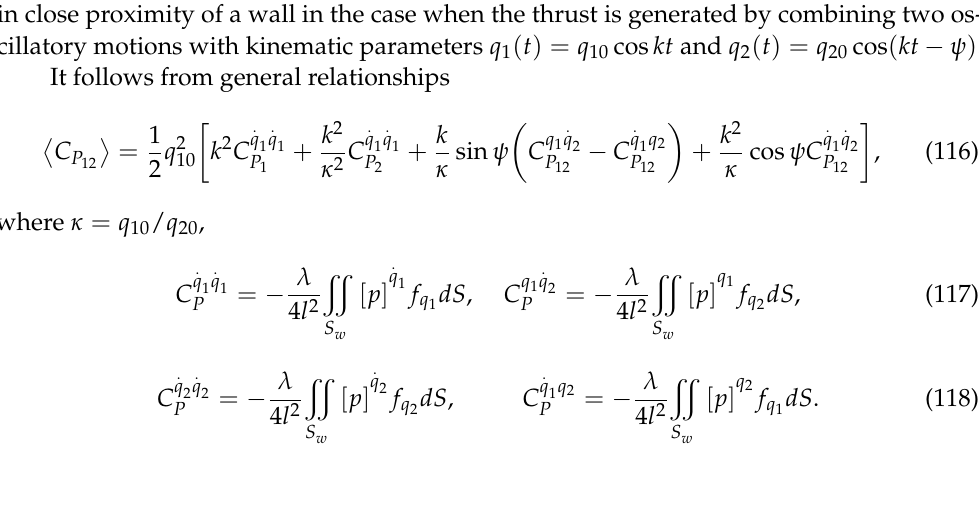
Figure 17. Thrust in the case of combined heaving-pitching oscillations related to that for purely heaving oscillations versus amplitude ratio for different Strouhal numbers.